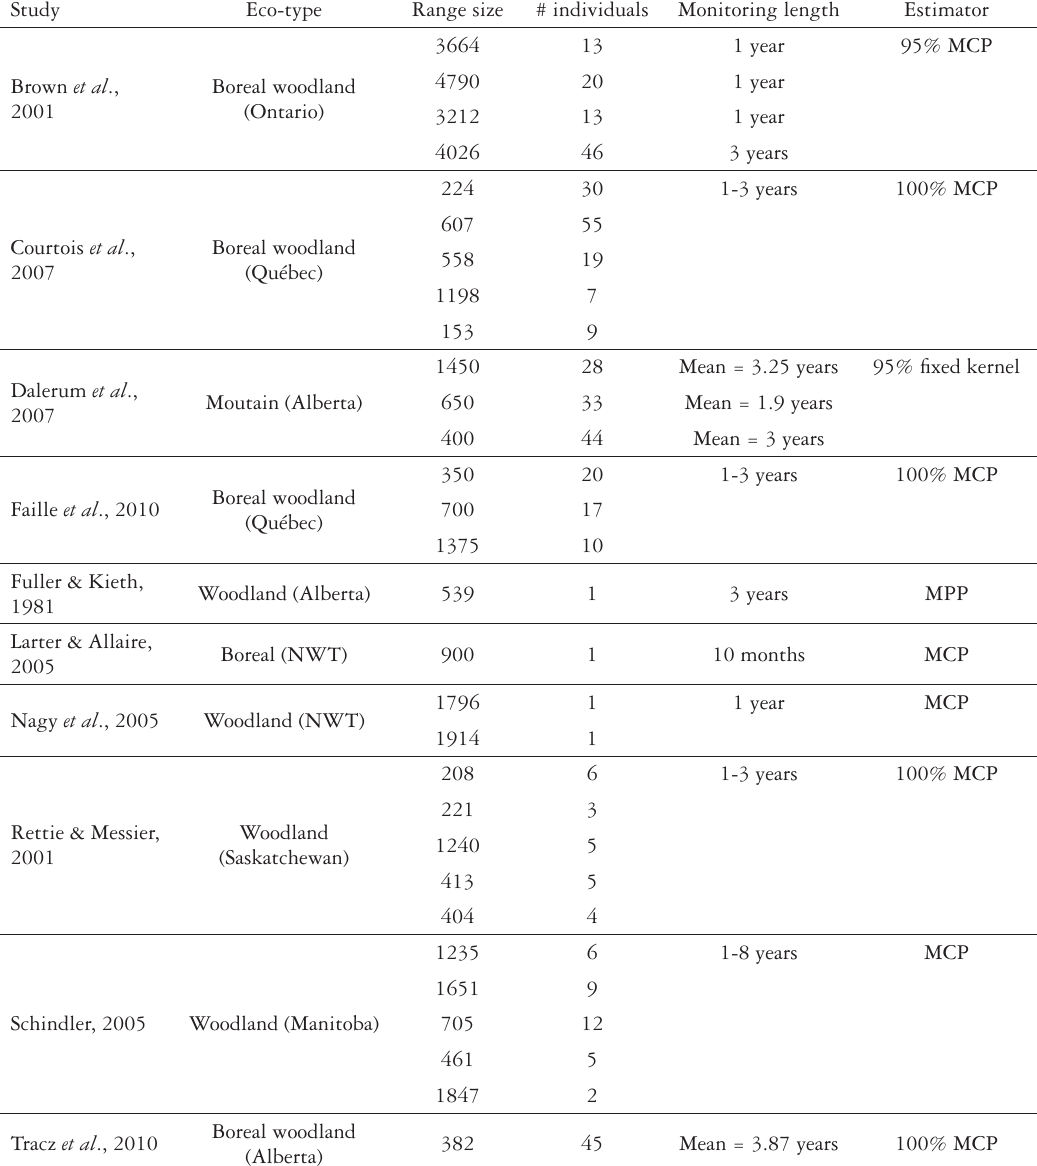
Table 3. Summary of studies reporting home range sizes for woodland